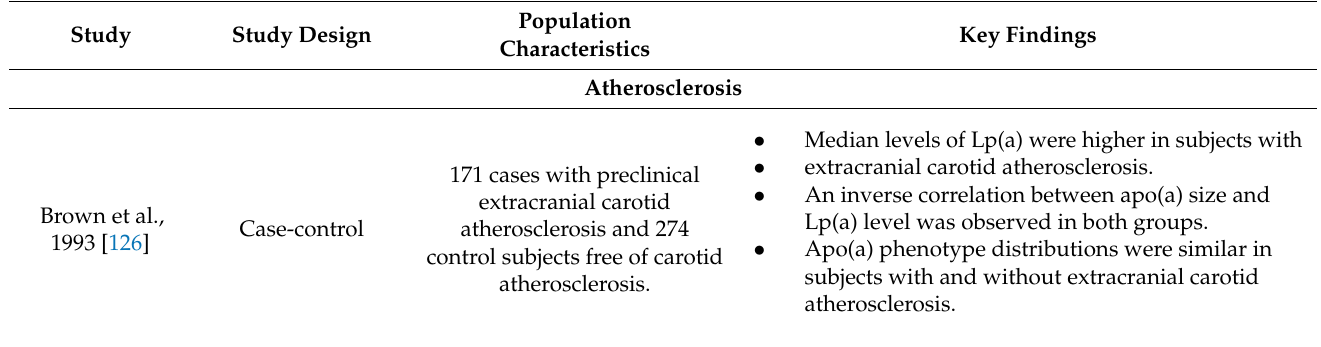
Table 1. Studies investigating the role of lipoprotein(a) in atherosclerosis, thrombosis, inflammation and endothelial